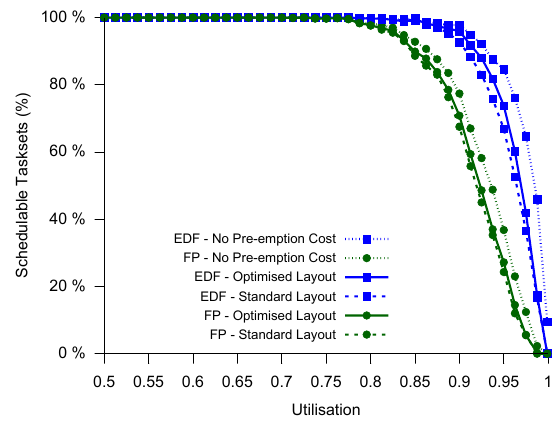
Figure 6 Percentage of schedulable tasksets at each utilisation level for the PapaBench benchmark for tasksets of cardinality 10.